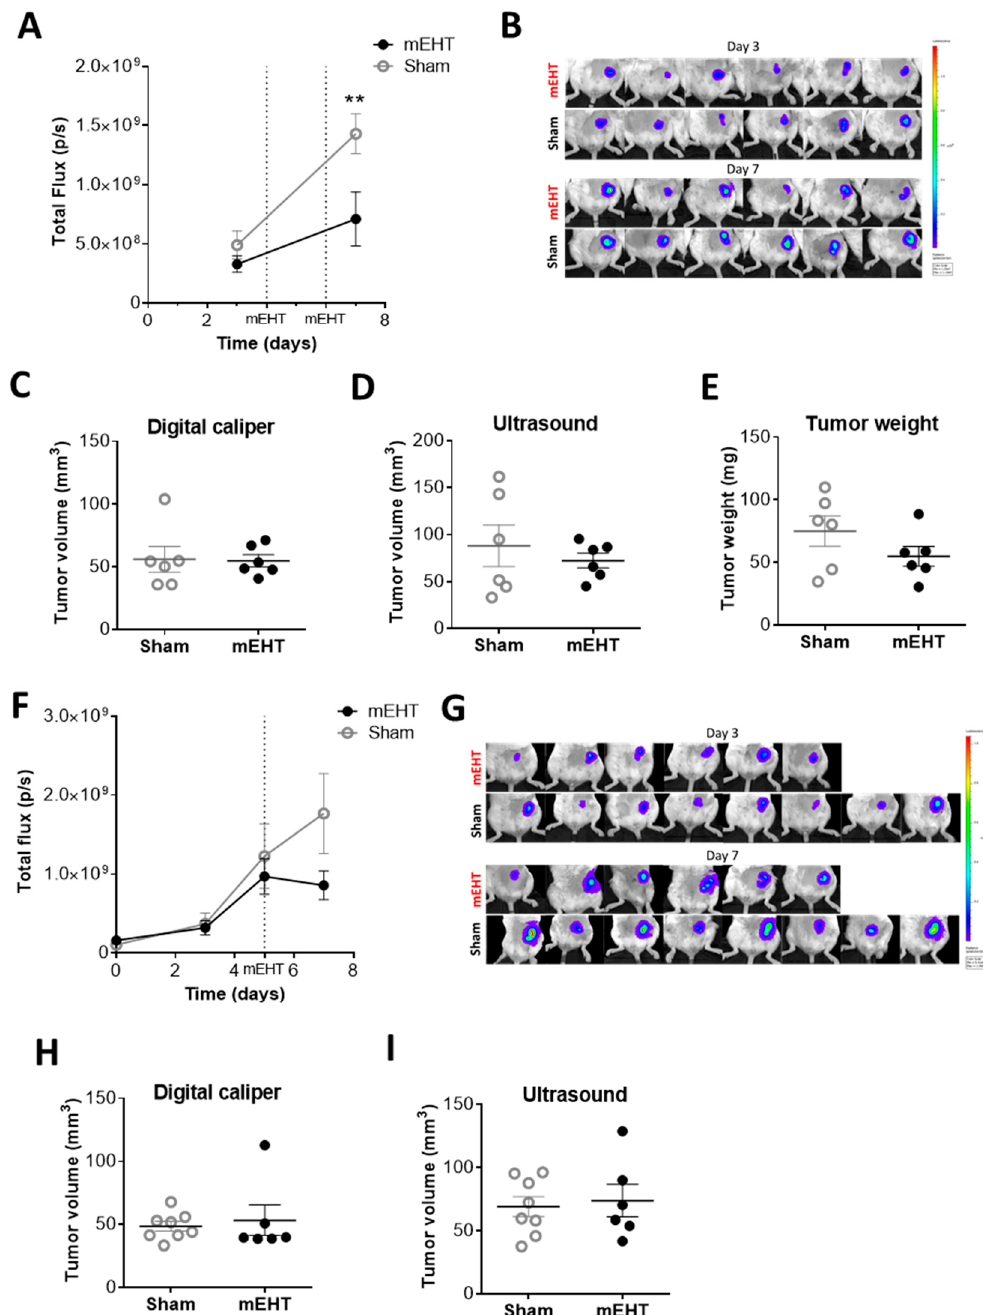
Figure 3. The e ff ects of modulated electro-hyperthermia (mEHT) on tumor size. ( A , B ) Total fluorescent flux measured by IVIS 24 h before and after two mEHT treatments; ( C – E ) Tumor volumes after two mEHT treatments, measured by a digital caliper ( C ) ultrasound ( D ) and tumor weight after removal ( E ) ( n = 6 / group); ( F , G ) Total fluorescent flux measured by IVIS before and after one mEHT treatment, at day 0, 3, 5, and 7; ( H , I ) Tumor volume after one mEHT treatment, measured by a digital caliper ( H ) and ultrasound ( I ). ( n sham = 4, n mEHT = 6. Mean ± SEM; ( A , F ) two-way ANOVA, Bonferroni correction, ** p < 0.01; ( C – E , H , I ) Mann–Whitney test.